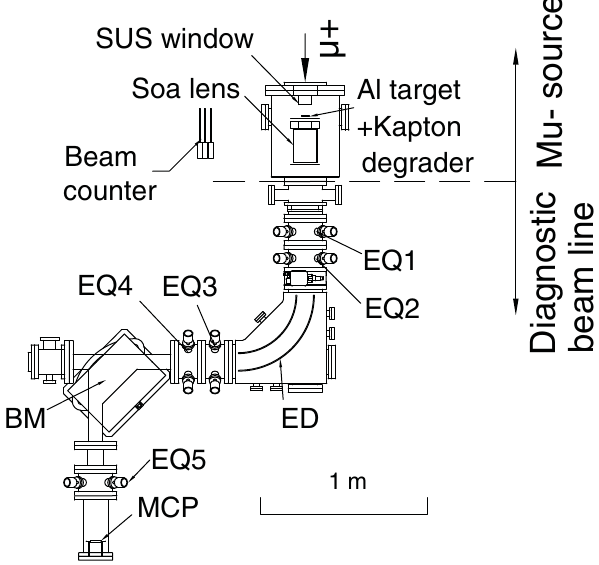
FIG. 1. Schematic drawing of an experimental setup of the Mu − ion production experiment. A detailed description of the diag- nostic beamline is given in the text.